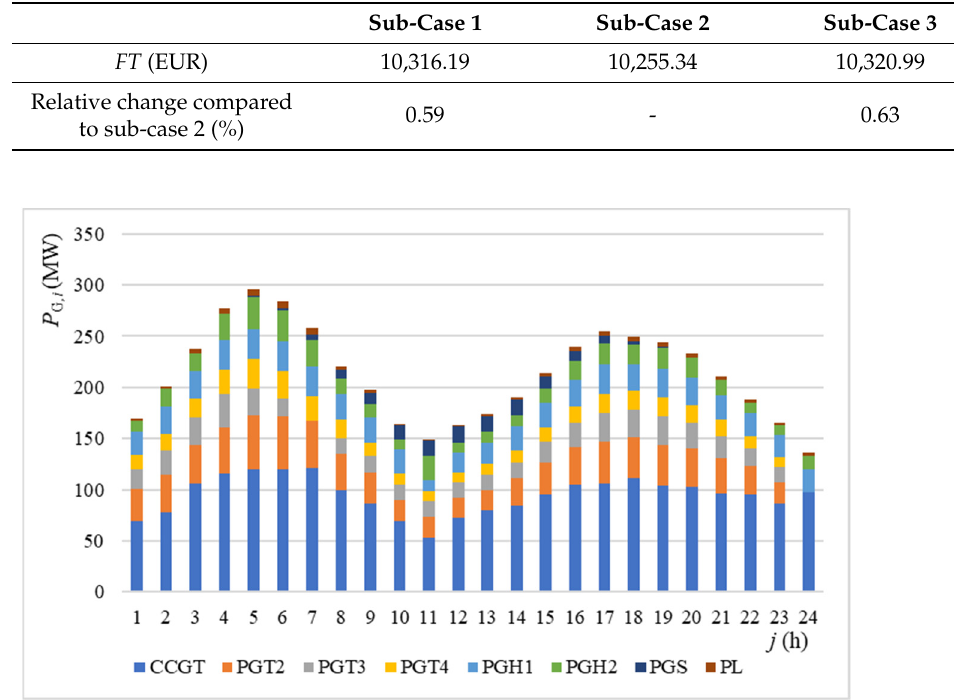
Figure 9. Optimal generation scheduling for case 1–sub-case 1.